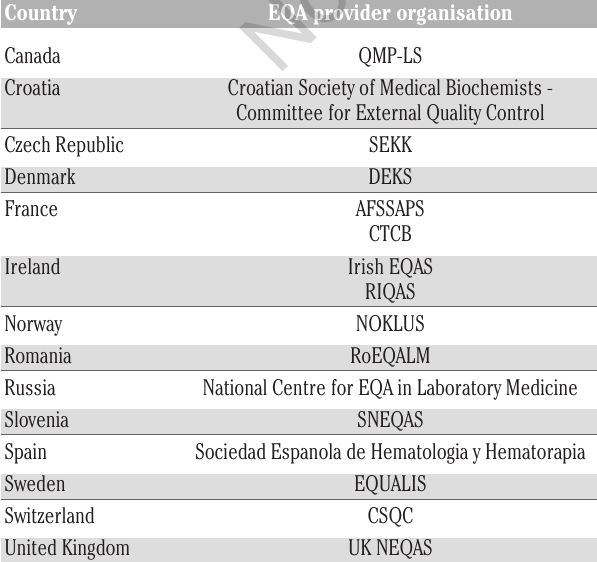
Table 1. Responses received to questionnaire ENQUE-H2 Country